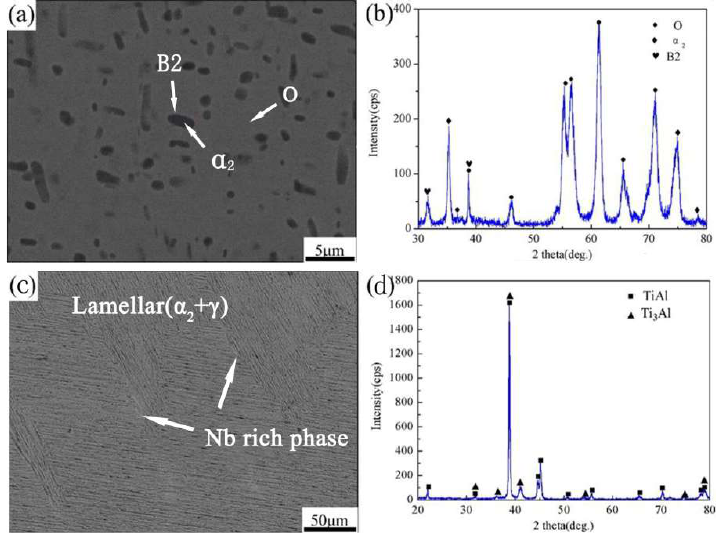
Figure 1. Microstructure and X-ray diffraction (XRD) patterns of substrates. ( a , b ) Ti 2 AlNb, ( c , d ) TAN.